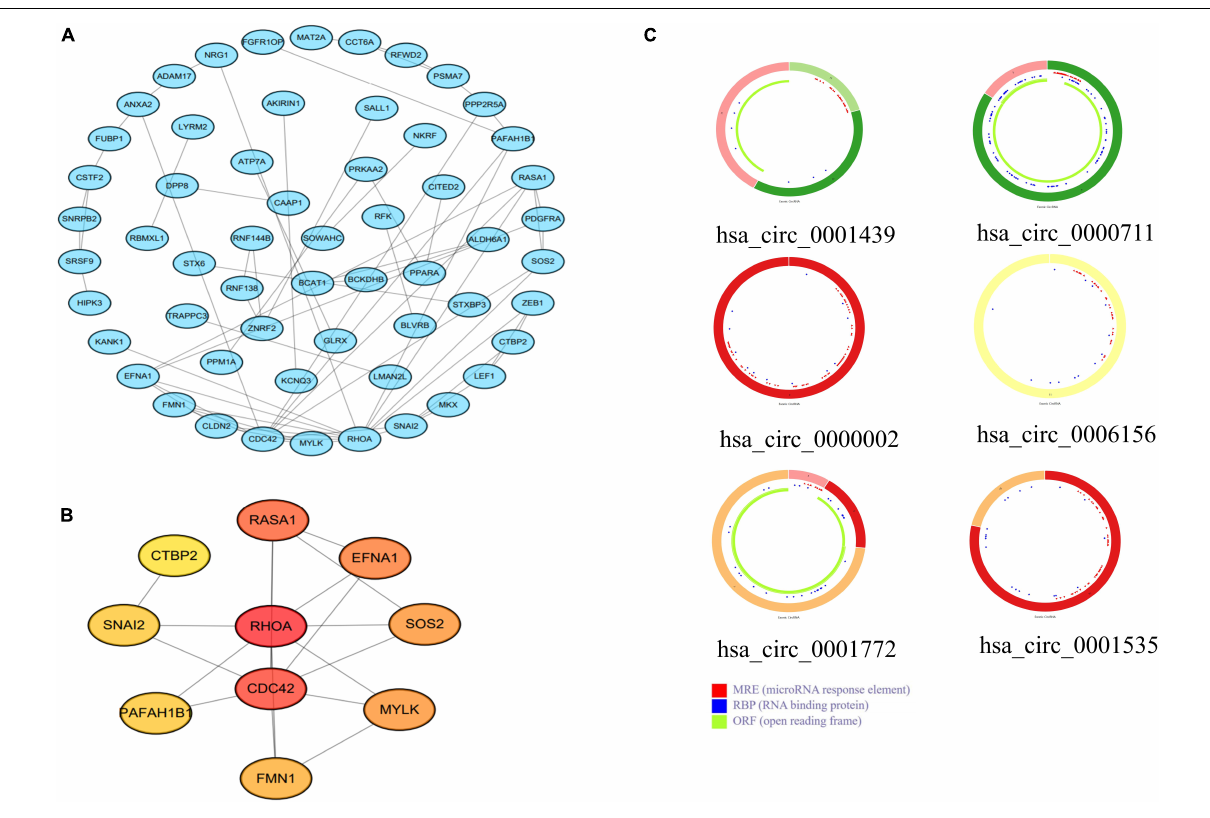
Frontiers in Genetics |